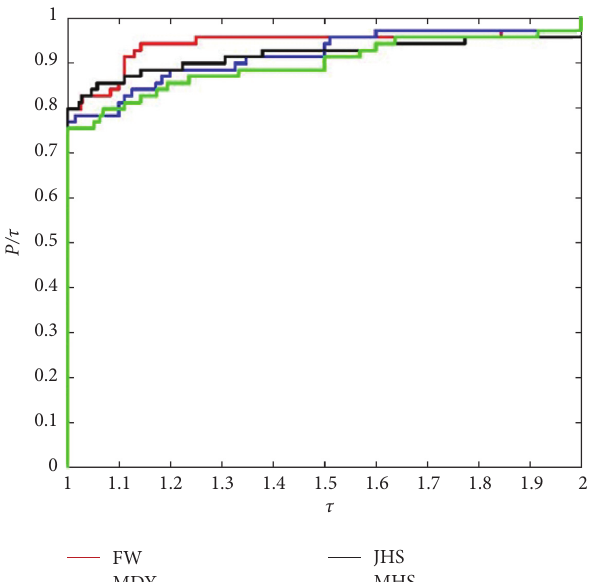
Figure 2: Performance profile on the number of gradient evaluation (FW versus MDY, JHS, and MHS).